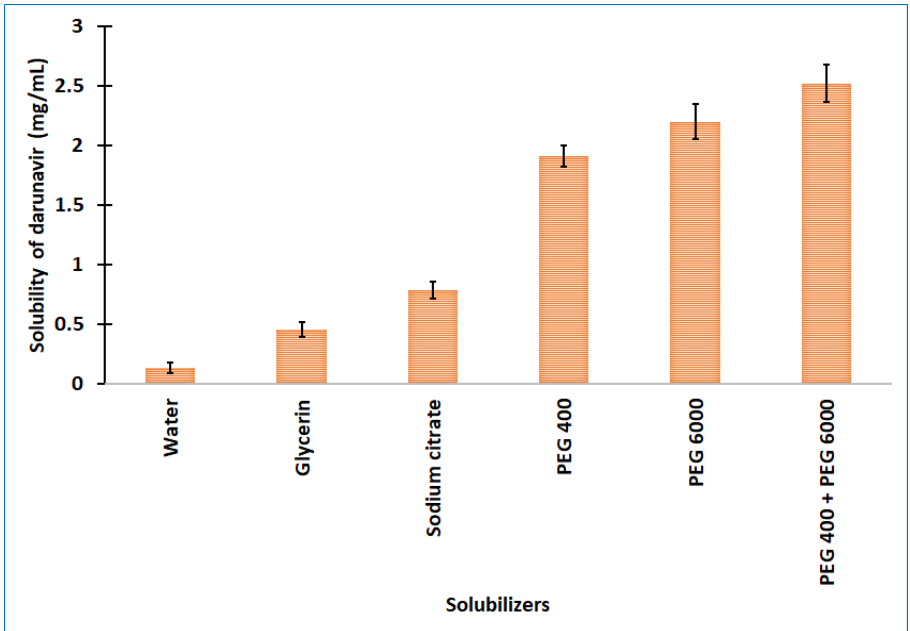
Figure 2. Solubility of darunavir in various solubilizers determined. The data presented are the average ± SD ( n = 6). PEG: polyethylene glycol.